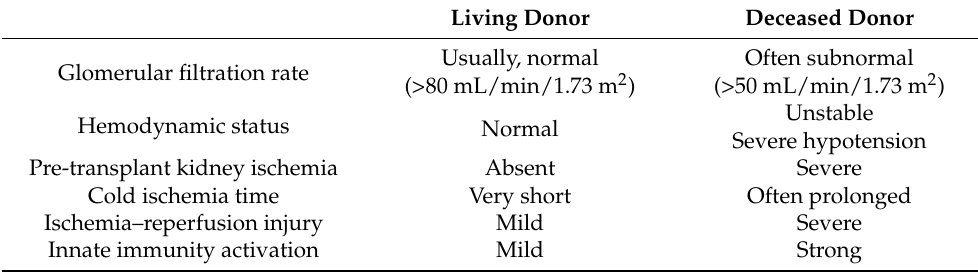
Table 2. Factors that determine better outcomes in living-donor transplant. Living Donor Deceased